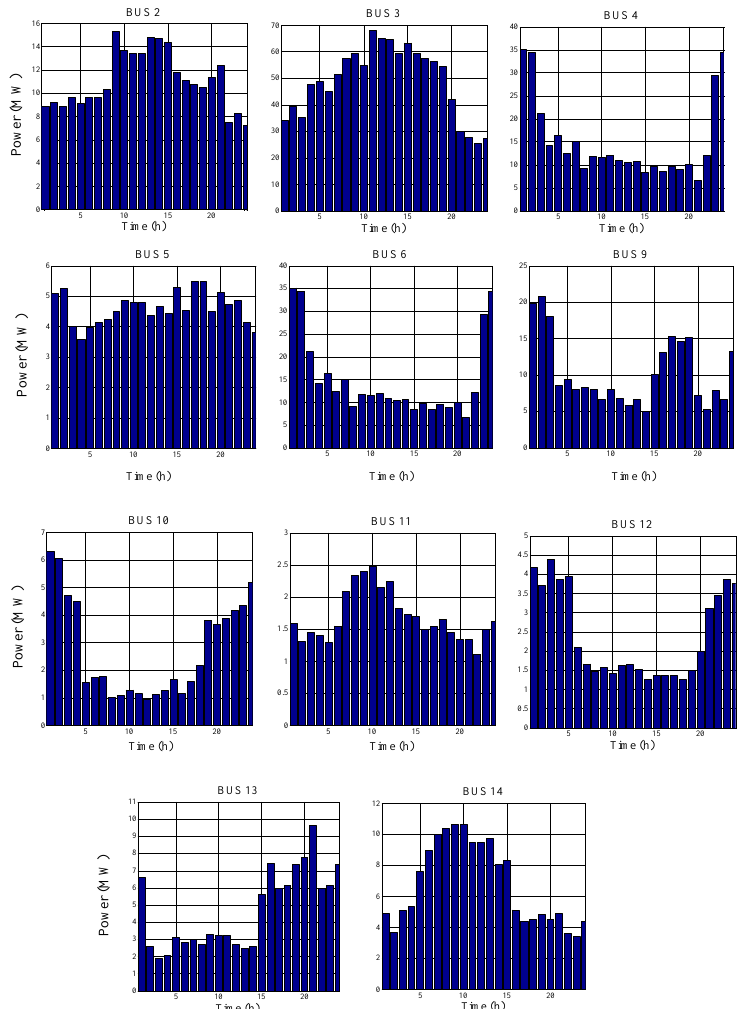
Figure 10. Case 1: testing loads for VPP system, including the IEEE 14-bus test system.